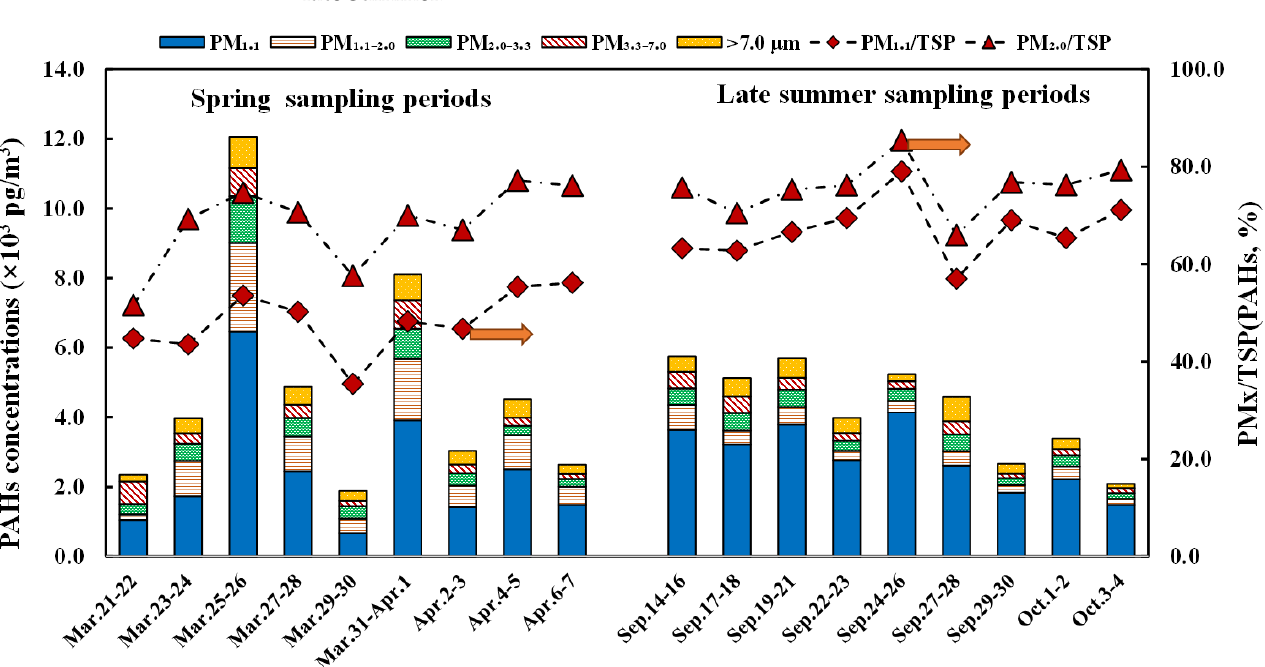
Figure 2. PAHs size distribution at each sampling case during the spring and late summer sampling periods.